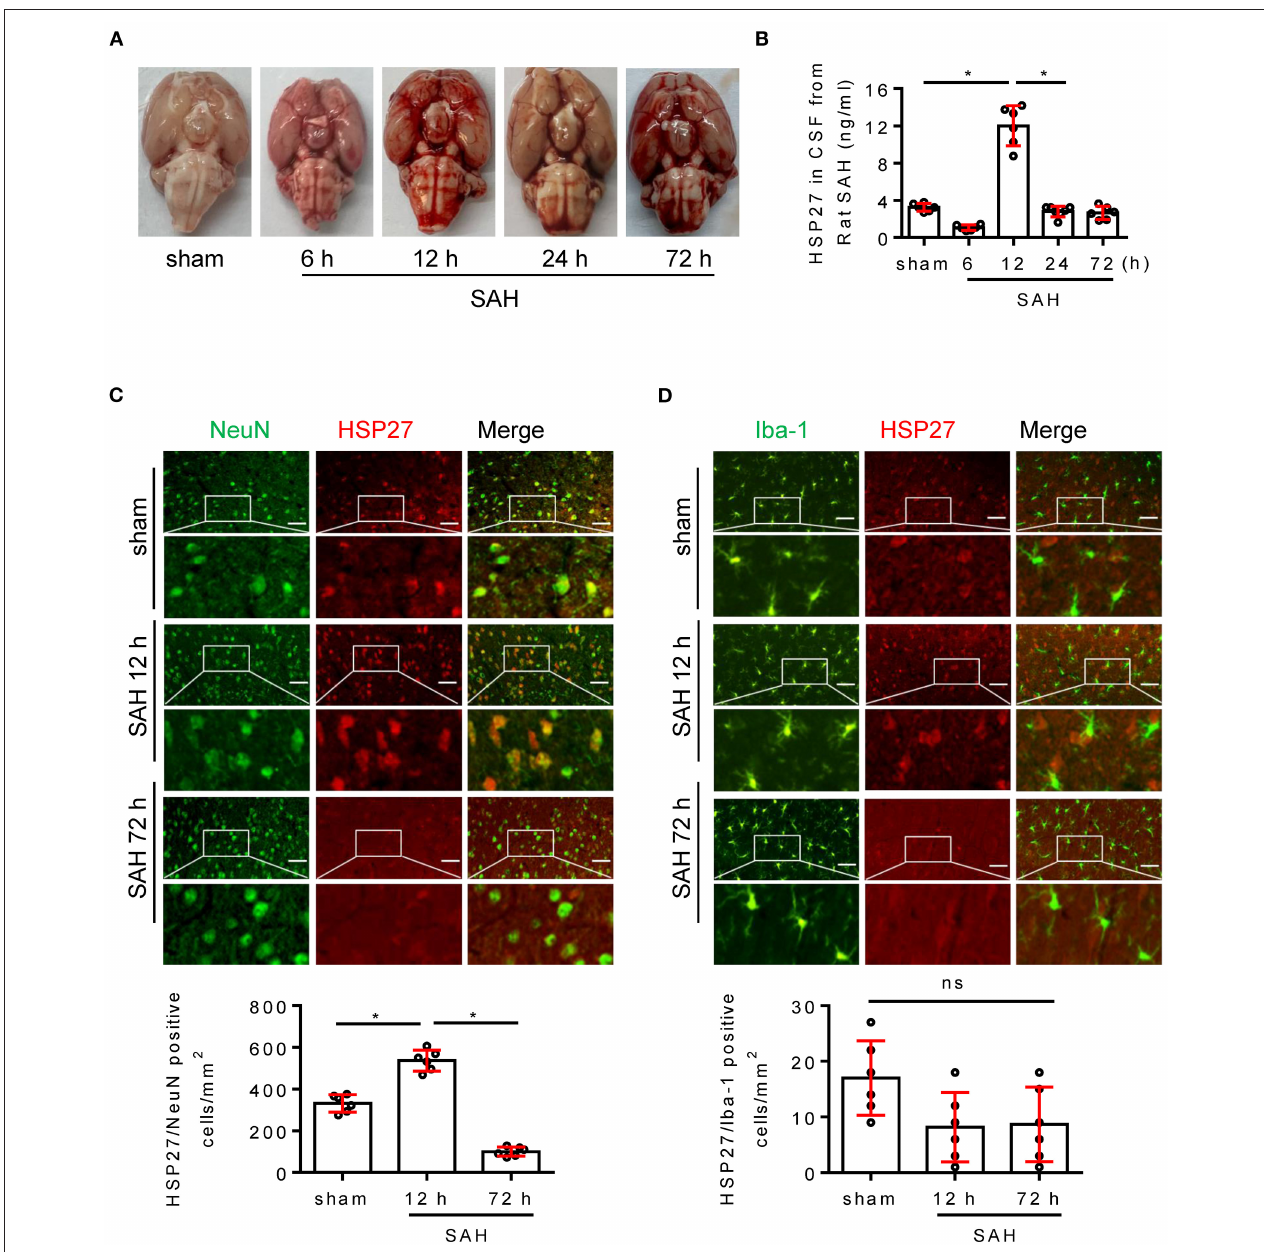
FIGURE 2 | Change of HSP27 level in rat SAH model. (A) Representative images of rat brain at indicated time from the sham and SAH groups. (B) Samples of CSF was collected (6, 12, 72h, n = 6; 24h, n = 7), HSP27 concentration was measured with HSP27 ELISA Kit and expressed in ng/ml. (C,D) Coronal sections from the sham and SAH group reperfusion (12 and 72h) subjected to immunostaining for the neuronal marker NeuN (green) or macrophages/microglia marker Iba-1 (green) and HSP27 (red) in the basal cortex. Quantification was performed by counting the HSP27/NeuN or HSP27/Iba-1 positive cells per mm 2 region in the basal cortex, n = 6, scale bar = 50 µ m. Data are mean ± SD, * p < 0.05, ANOVA with Bonferroni’s multiple comparisons test.